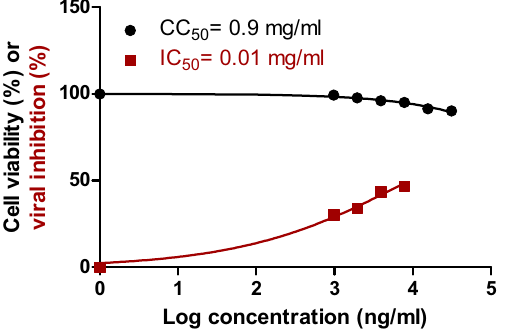
Figure 7. Dose–response and inhibition curves for ZINC000104379474 compound on VERO-E6 cells. Half maximal cytotoxic concentration (CC 50 ) in Vero E6 cells (black) and inhibitory concentration 50% (IC 50 ) against NRC-03-nhCoV were calculated using nonlinear regression analysis of GraphPad